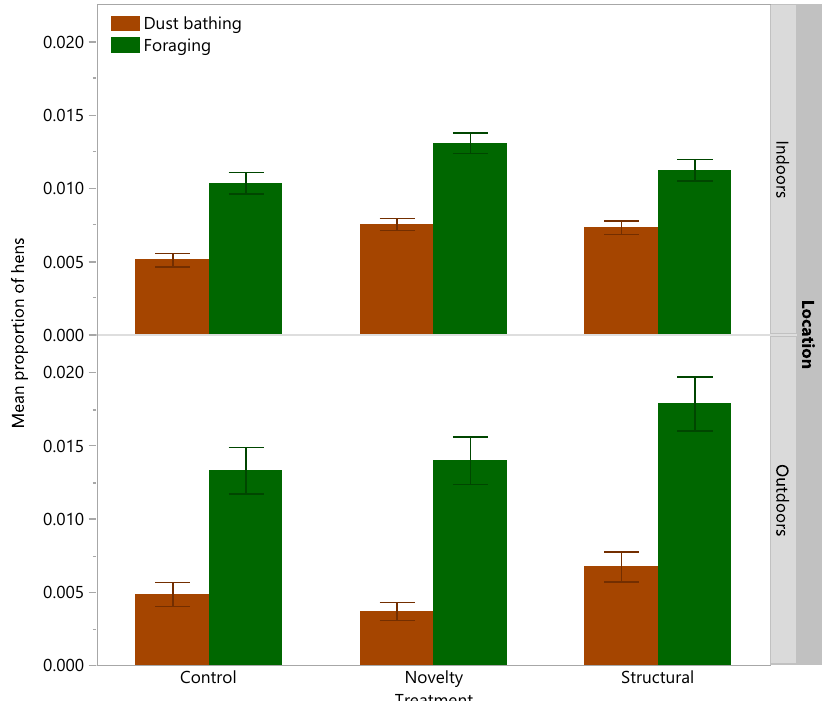
Figure 5. The mean ( ± SEM) proportion of hens inside the shed (indoors) or outside on the range (outdoors) exhibiting dust bathing or foraging behavior across the flock cycle from three rearing treatments (control, novelty, structural). Raw data are presented.